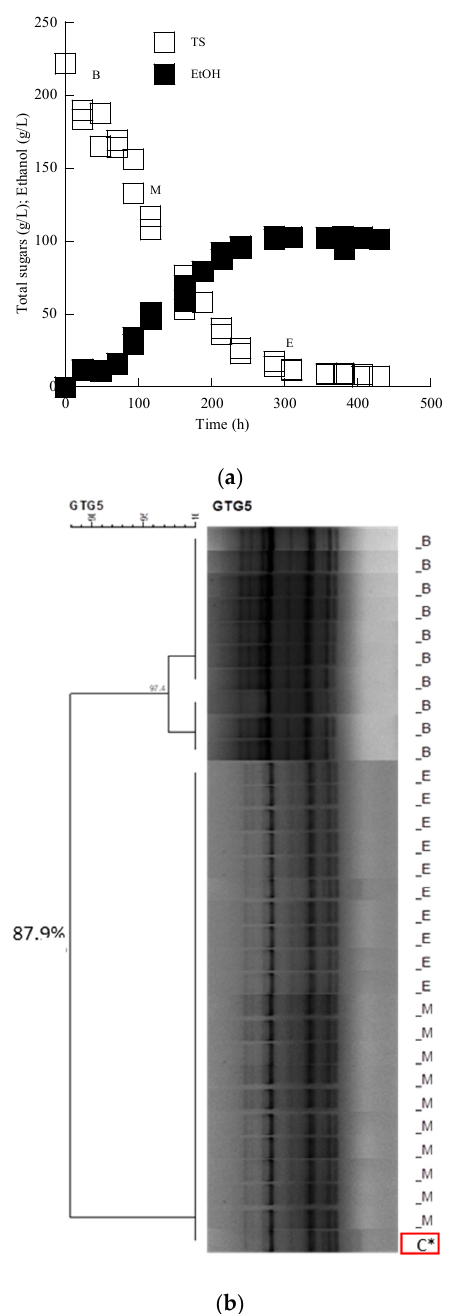
Figure 4. ( a ) Sugar and ethanol evolution of the S. cerevisiae Passion Fruit strain in must from the grape variety Assyrtiko. Each experimental point is the mean value of 2 independent measurements (SE for most experimental points ≤ 17%). ( b ) Dendrogram generated after cluster analysis of the digitized (GTG)5-PCR fingerprints of the 31 isolates from the beginning (B), middle (M) and end (E) of the fermentation kinetics in the grape must media. The control condition (C*) is the relative rep-PCR profile of the pure culture of the S. cerevisiae Passion Fruit strain. The dendrogram was constructed using the unweighted pair-group method using arithmetic averages with correlation levels expressed as percentage values of the Pearson correlation